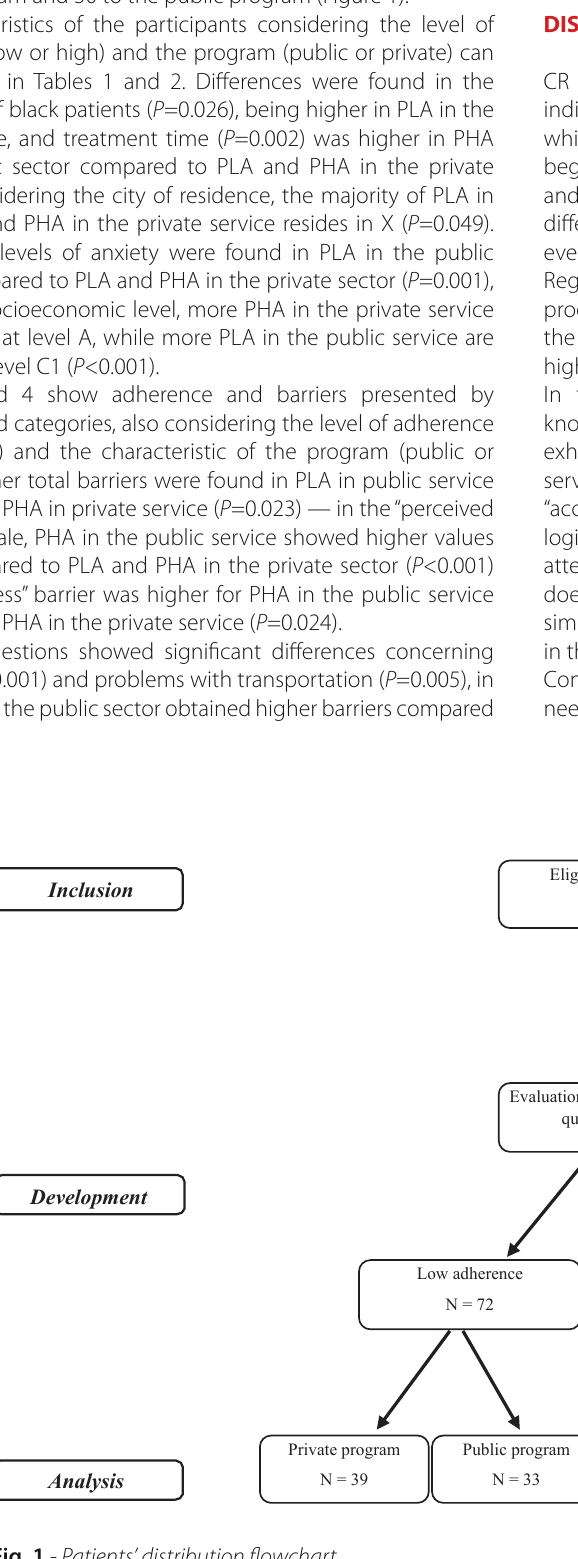
Figure 1. Loss flowchart.